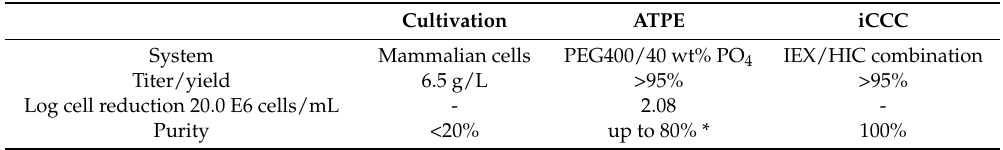
Table 4. Process related data of the cultivation, ATPE, and iCCC. Yield and purity were determined using protein A chromatography and SEC, respectively.